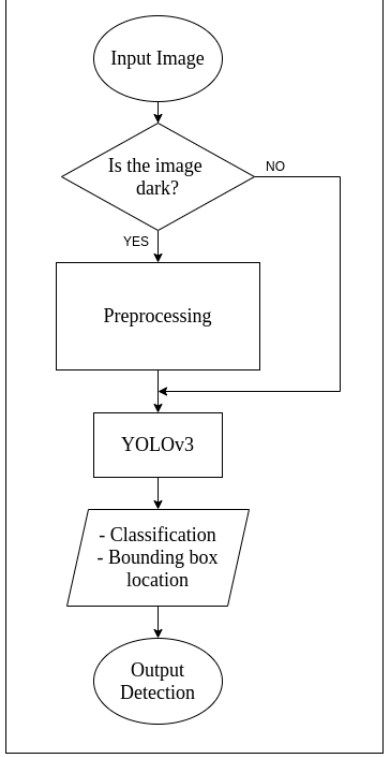
Figure 3. Flow diagram for YOLOv3.